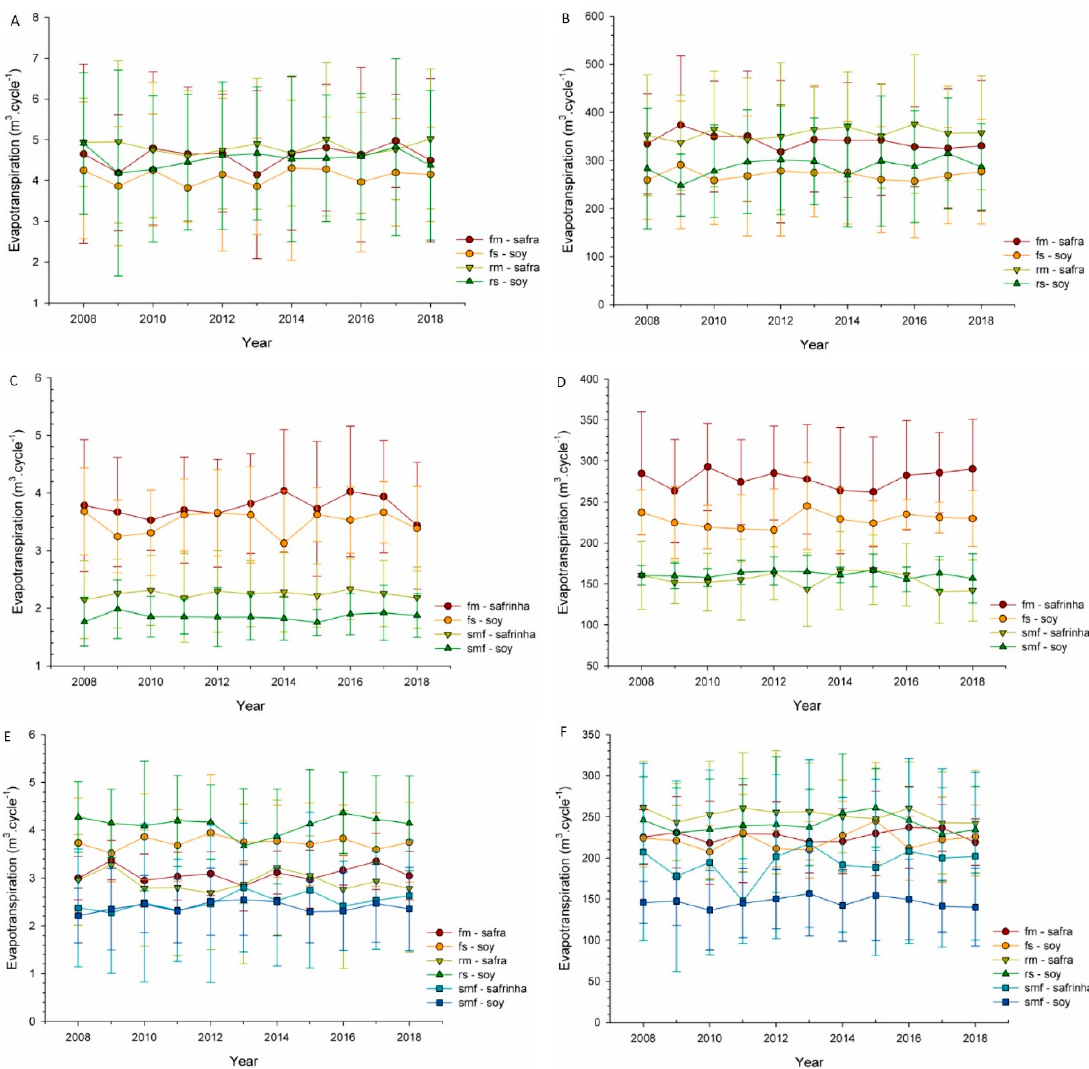
Figure 6. Uncertainty data analyzes—Monte Carlo. A : RS—broiler feed; B : RS—pig feed; C : MT—broiler feed; D : MT—pig feed; E : PR—broiler feed; F : PR—pig feed.